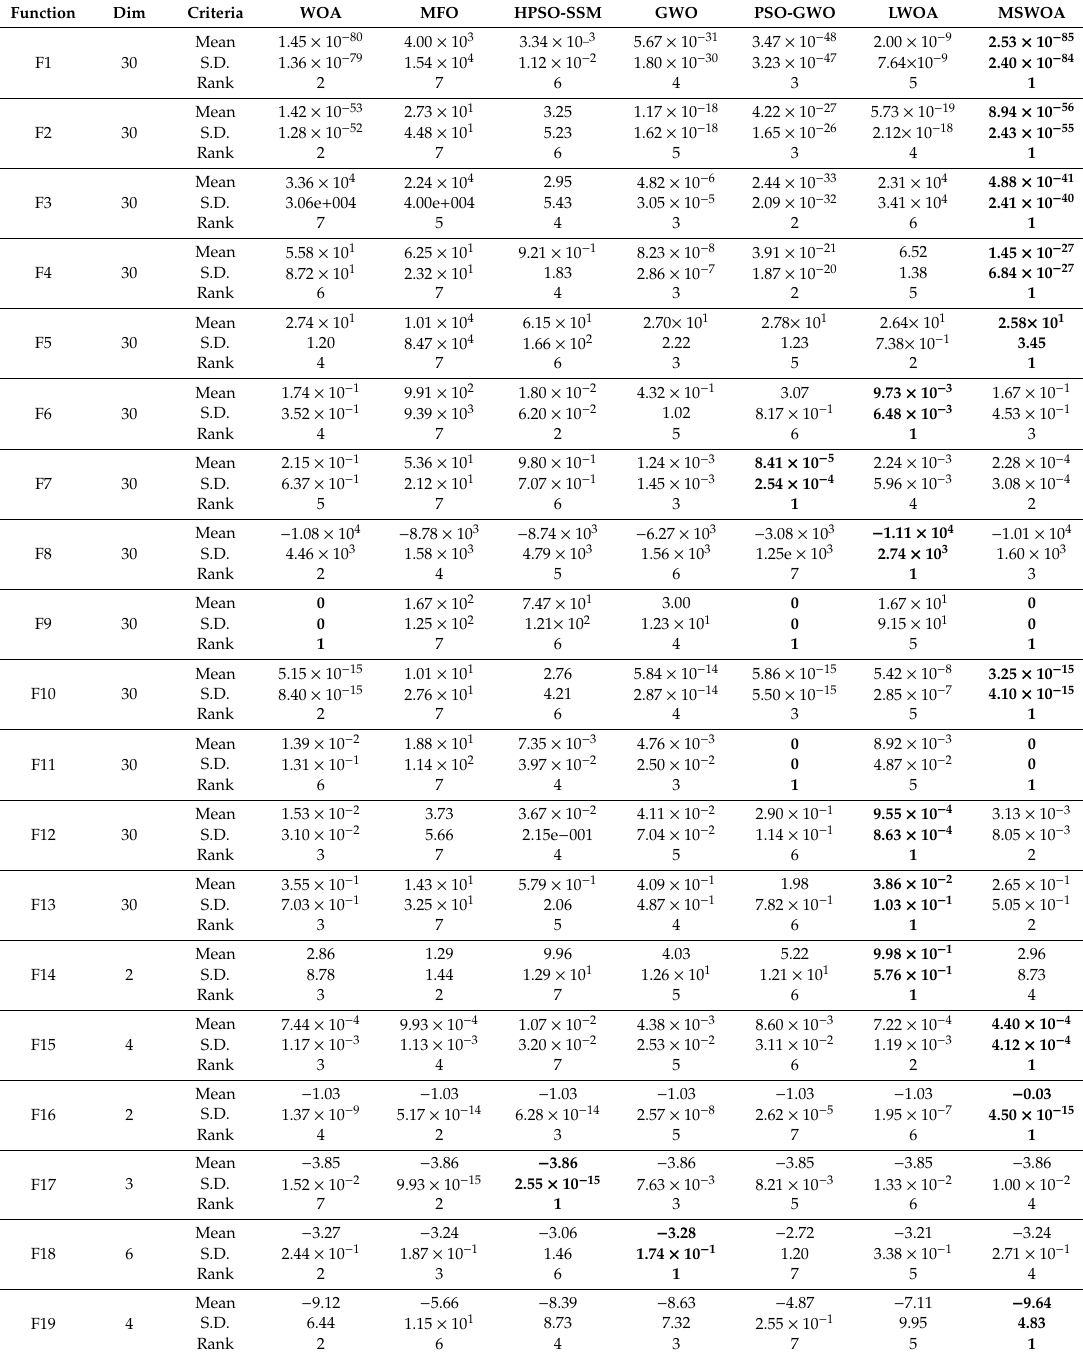
Table 3. Numerical optimization simulation results of WOA, MFO, HPSO-SSM, GWO, PSO-GWO, LWOA, and